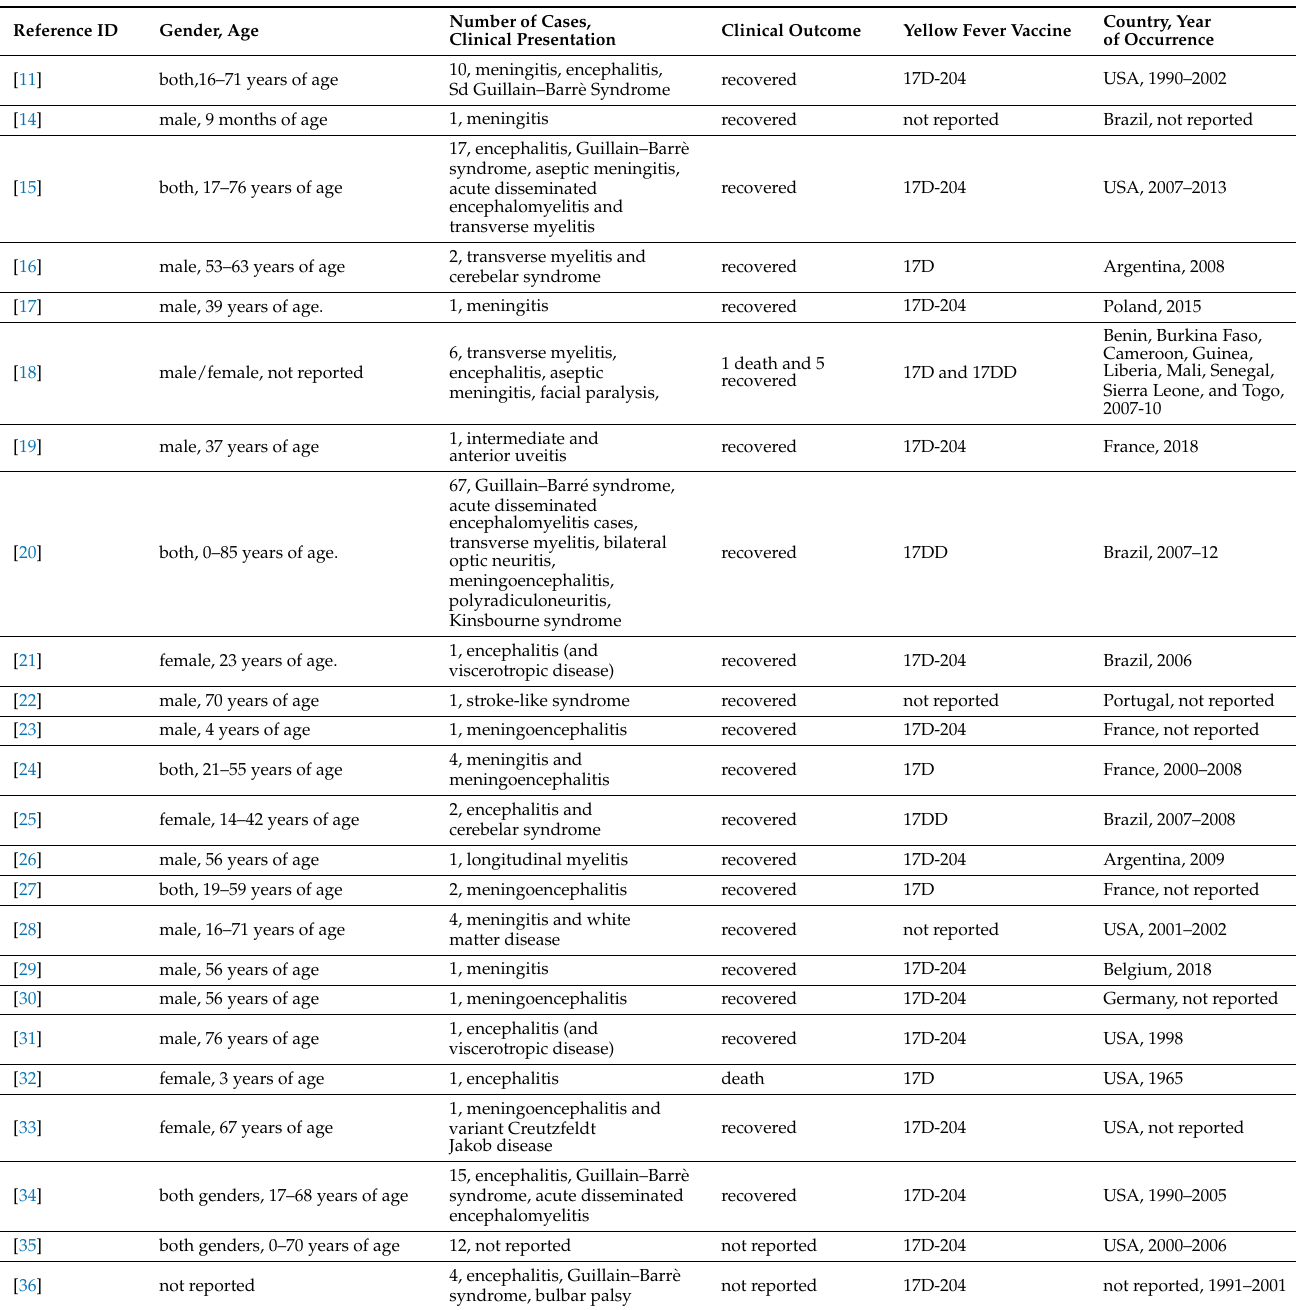
Table A1. Cases of Yellow Fever vaccine-related neurological disease reported in main